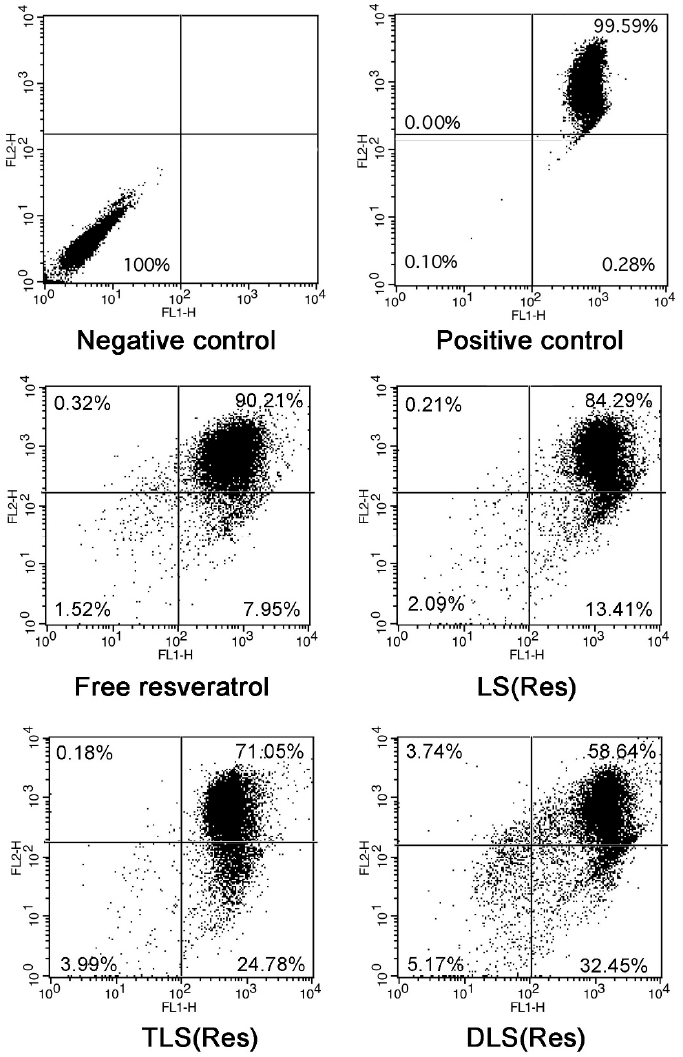
Figure 10. Mitochondrial depolarization of free resveratrol, LS (Res), TLS (Res) and DLS (Res) after 12 h incubation using flow cytometry.